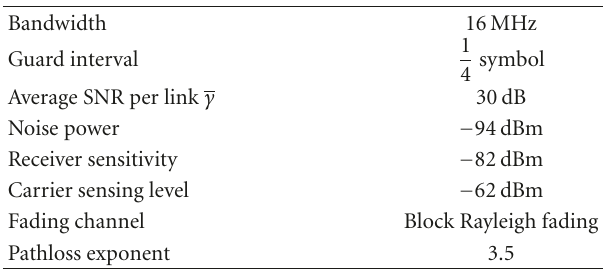
Table 5: Physical channel